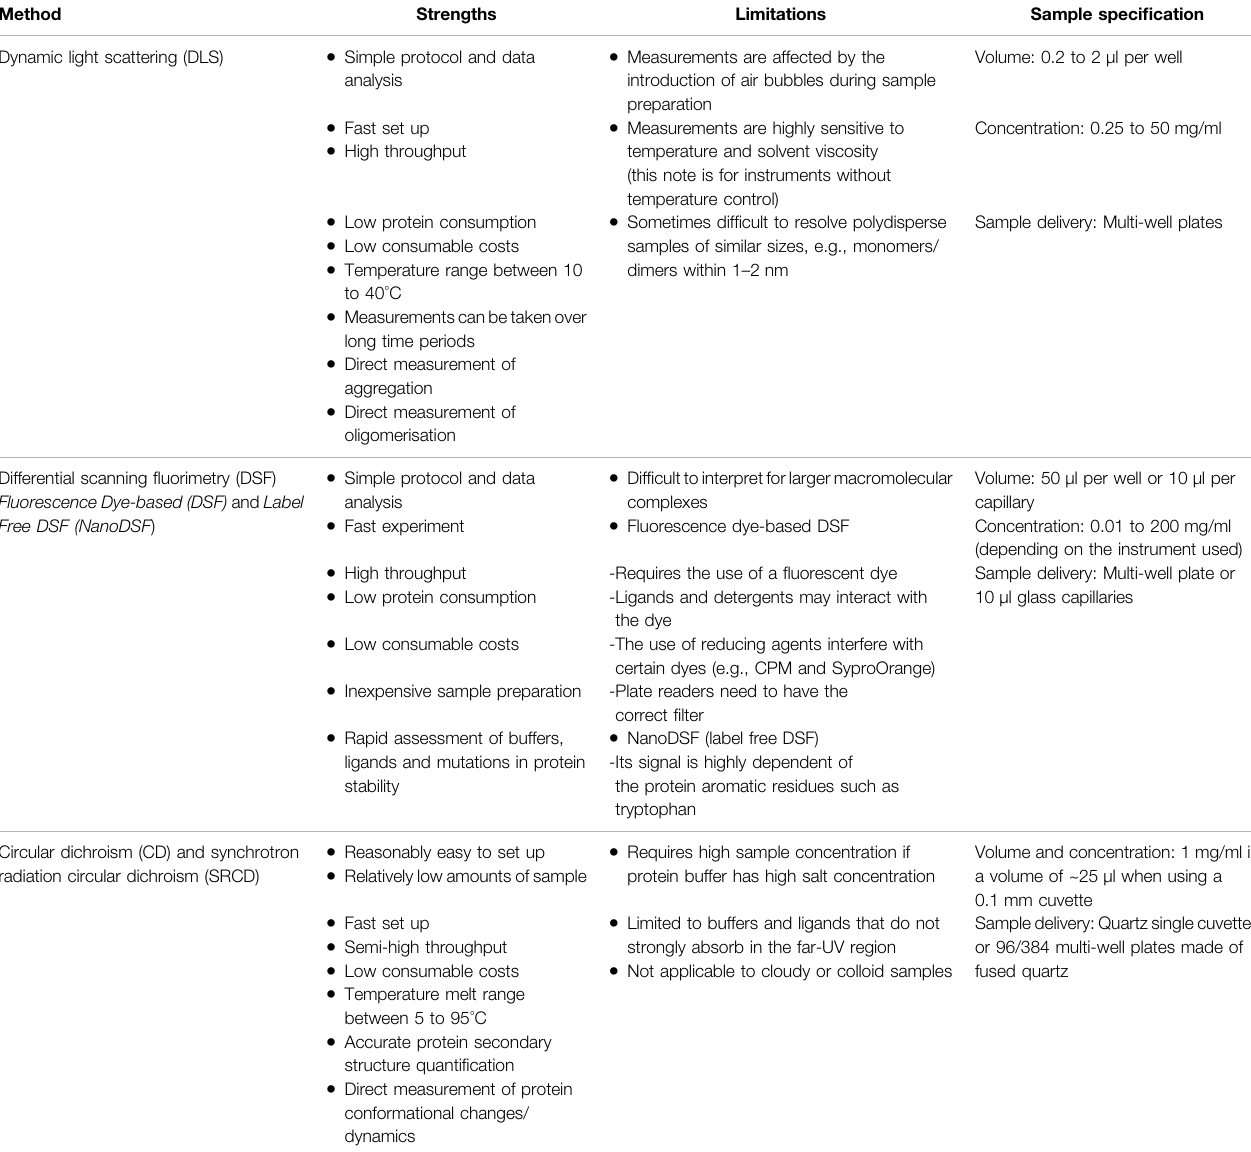
TABLE 1 | Summary of the strengths and limitations of the HTP biophysical methods presented in this perspective.